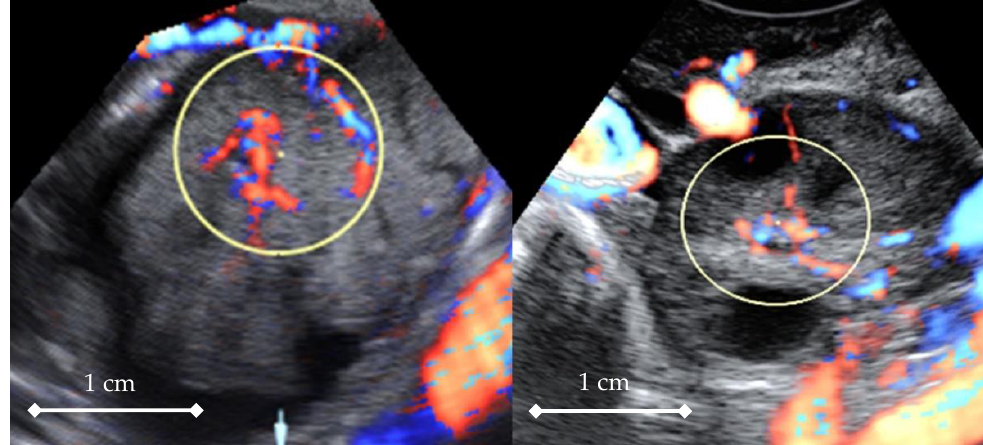
Figure 4. Ovarian tumor—an example of virtual spherical sampling of the most vascularized part of the tumor tissue—systole ( left ); and normal ovary—systole ( right ).